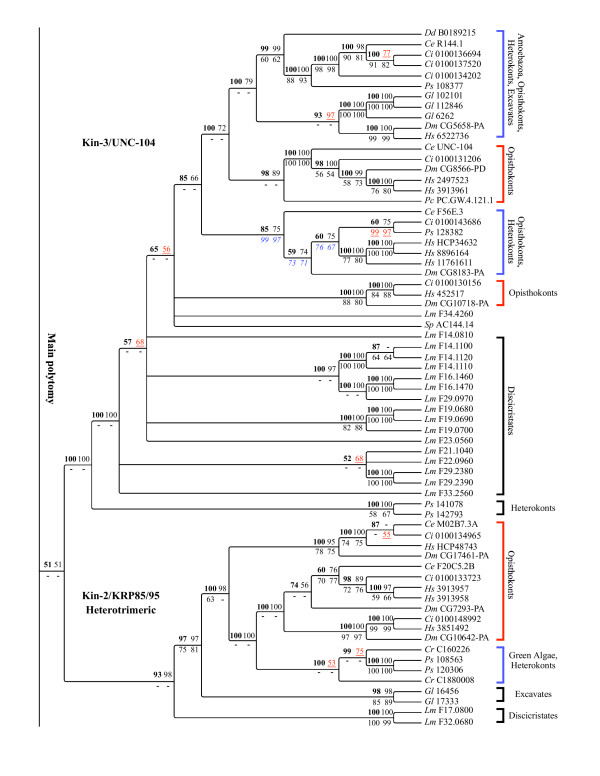
Expanded view of Kinesin-2 and Kinesin-3 families. Expansion of the Kinesin-2 and Kinesin-3 families from Fig. 2. There are no plant kinesins present in either of these families. Red brackets indicate opisthokonts, mixed clades are shown in blue brackets and black brackets indicate protozoan species. See Fig. 2 legend for an explanation of support values. For full names of species see Fig. 1 legend.